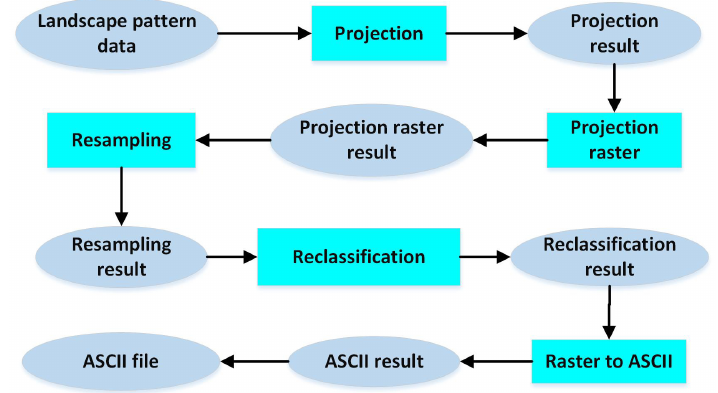
Figure 3. Process used to generate the land-use data.